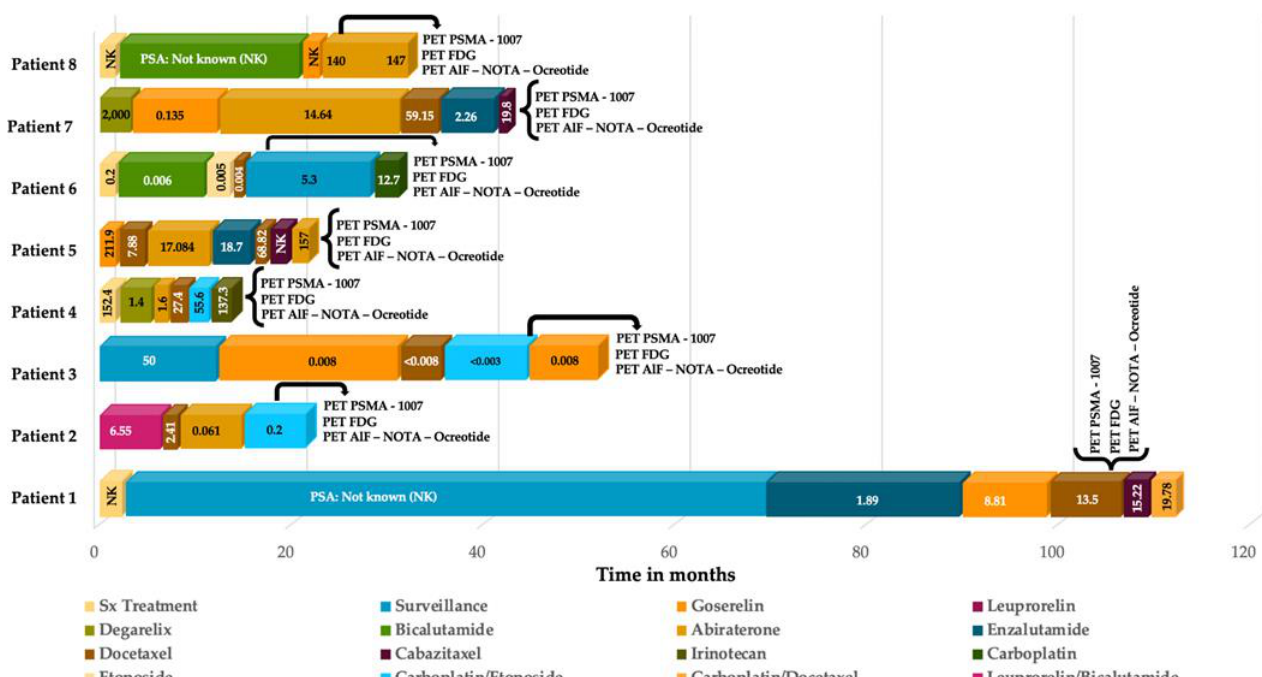
Figure 6. Therapy and PSA correlation analysis per patient.